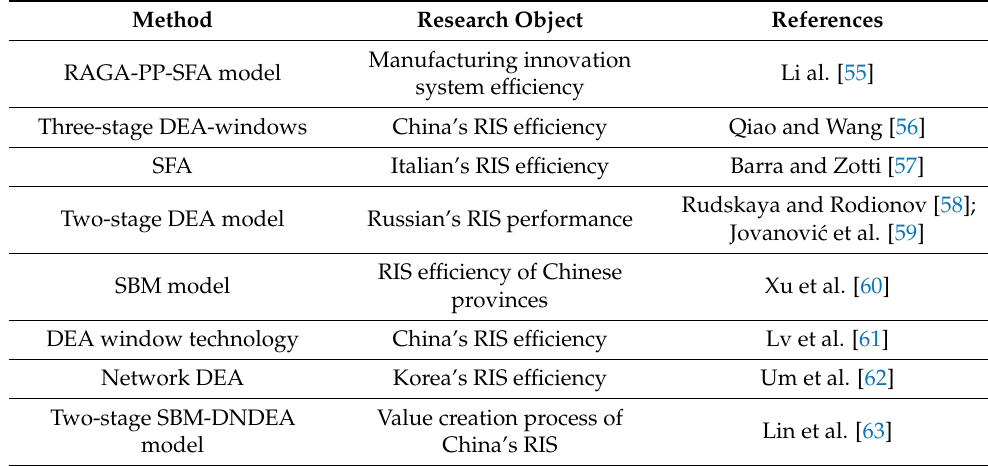
Table 1. Main evaluation methods of regional innovation